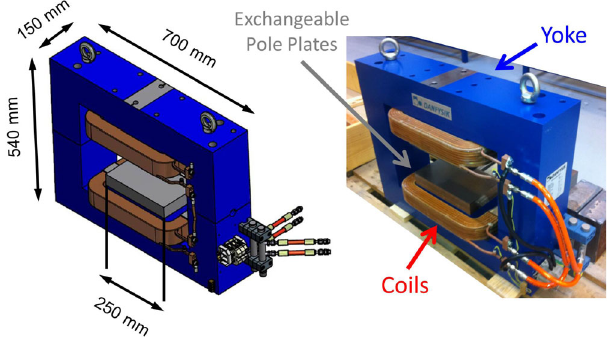
FIG. 7. Drawing (left) and photograph (right) of the chopper dipole.